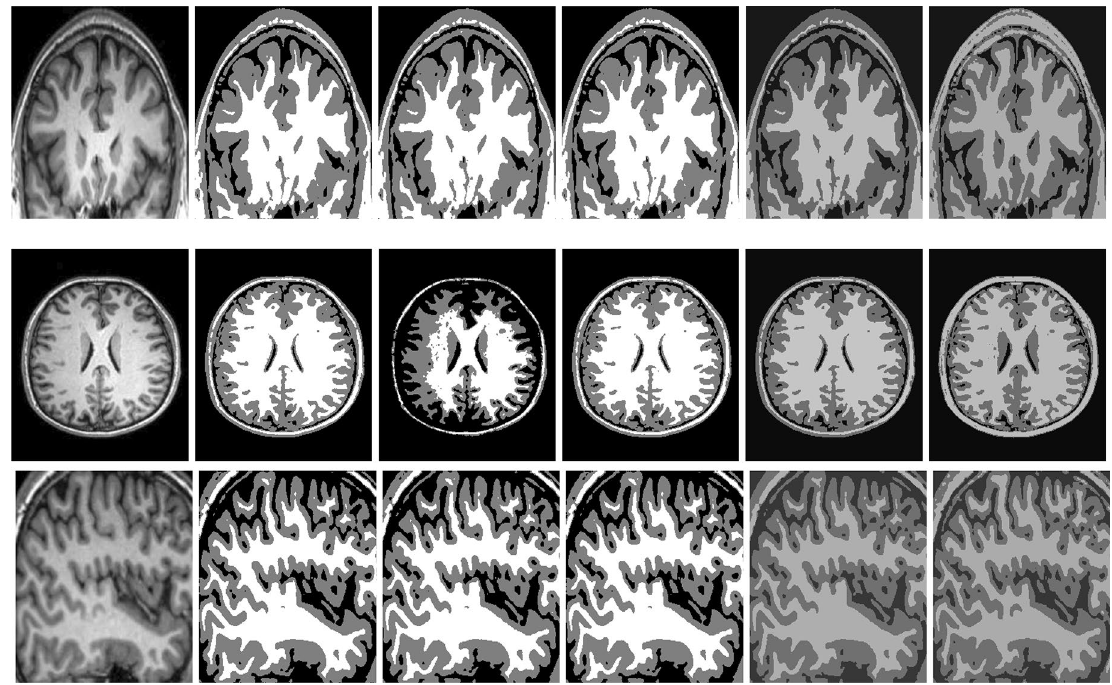
Figure 10. Segmentation results on three dissimilar MR images of the brain. Note that, these images were taken from the kaggle repository 33 . The first column out of the six columns represents original images, while second, third and fourth columns represent segmentation outcomes of ARKFCM a , ARKFCM m and ARKFCM w , respectively. Similarly, the fifth and the last column demonstrates segmented results of the Cai et al. 14 and M SAF L RR S models, respectively. In all these three experiments (three rows), the parameters used for our proposed model are (cid:31) 2 = 30 and k = 30 .